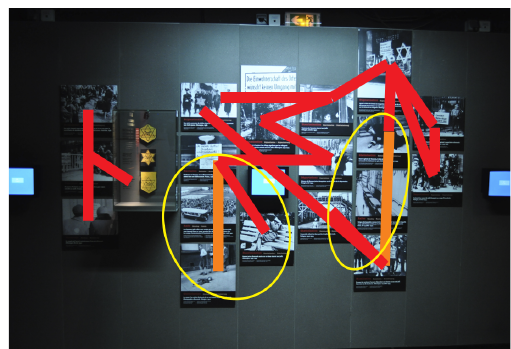
Figure 8: A. The gaze trajectories of 14 participants over a photo of the massacre of Ukrainian Jews in Mizocz, USSR. B. The densest points of